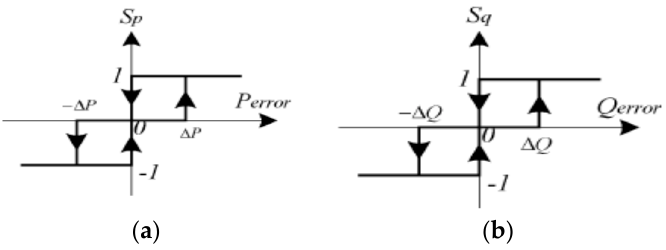
Figure 11. Three-level hysteresis comparators: ( a ) active power; ( b ) reactive power.